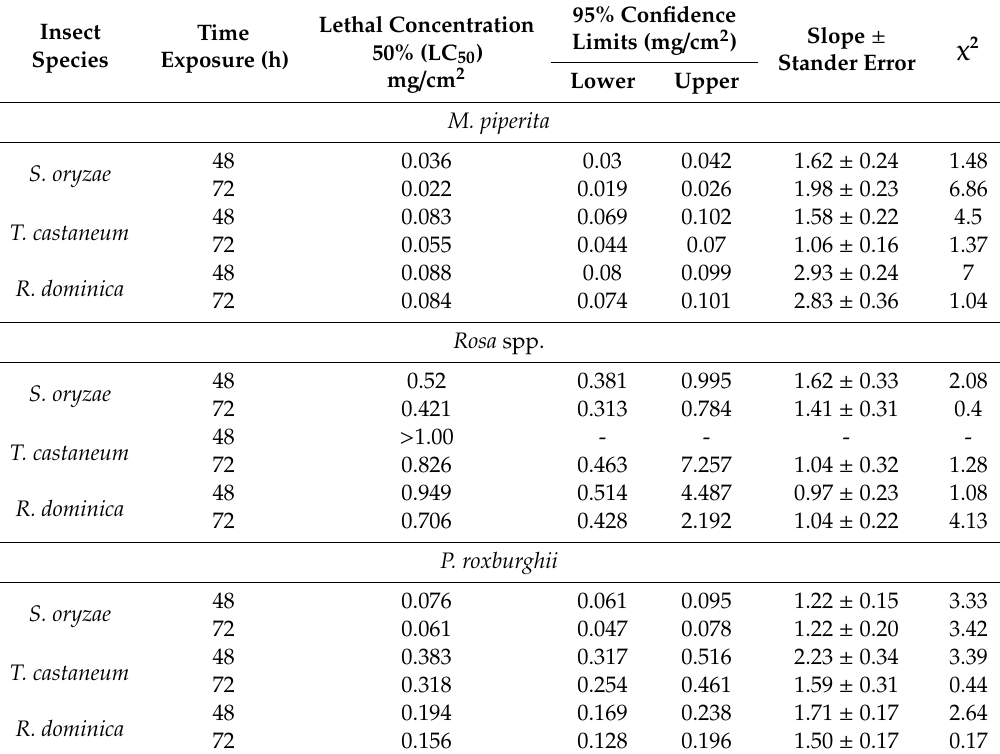
Table 4. Contact toxicity of the isolated M. piperita , Rosa spp., and P. roxburghii oils using residual film assays against Sitophilus oryzae , Tribolium castaneum , and Rhyzopertha dominica